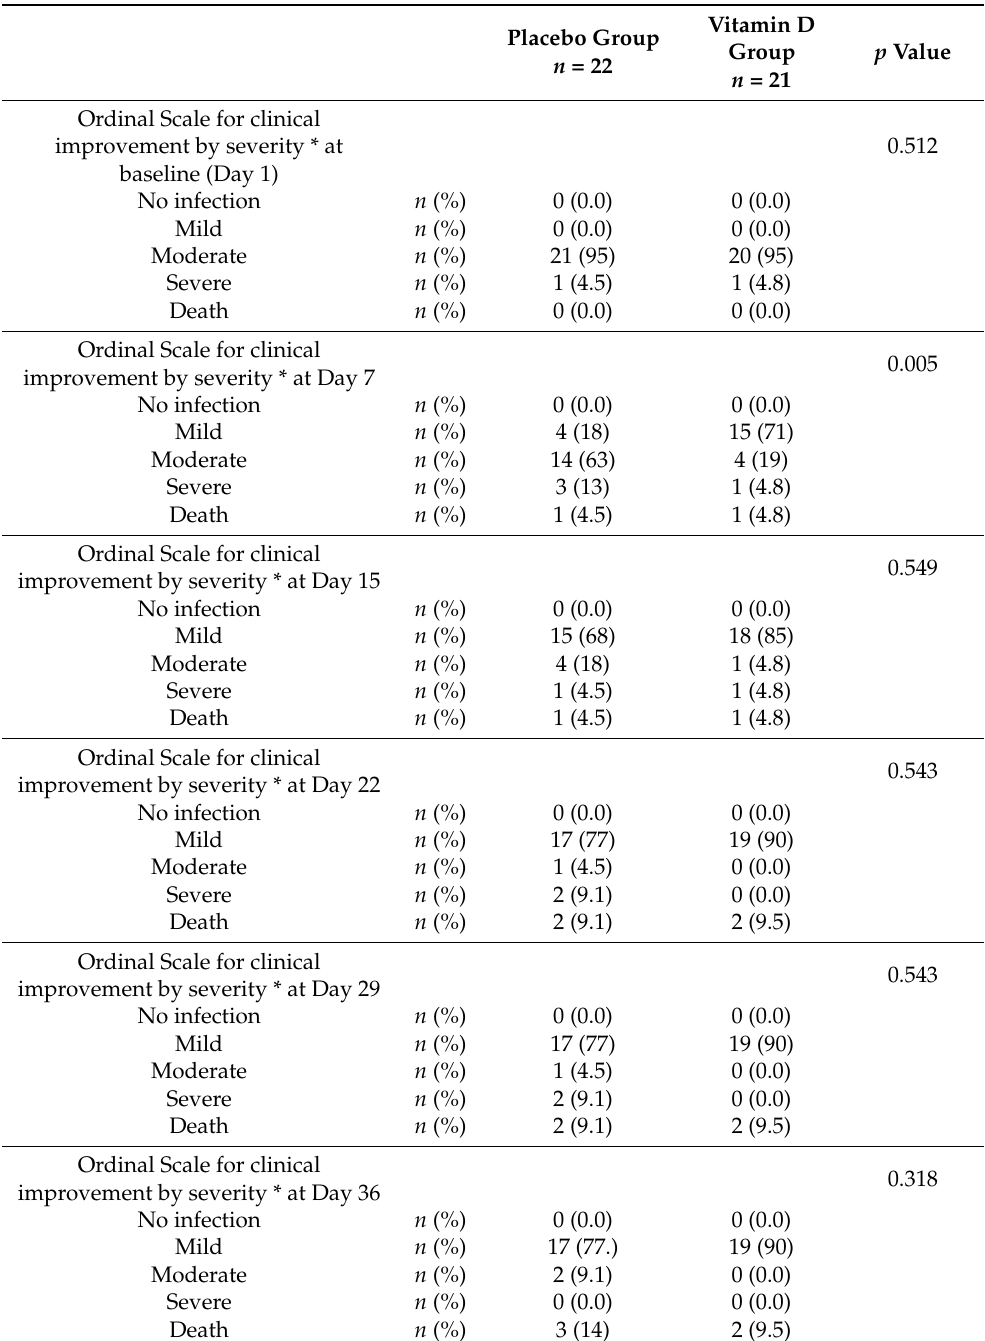
Table 4. WHO ordinal